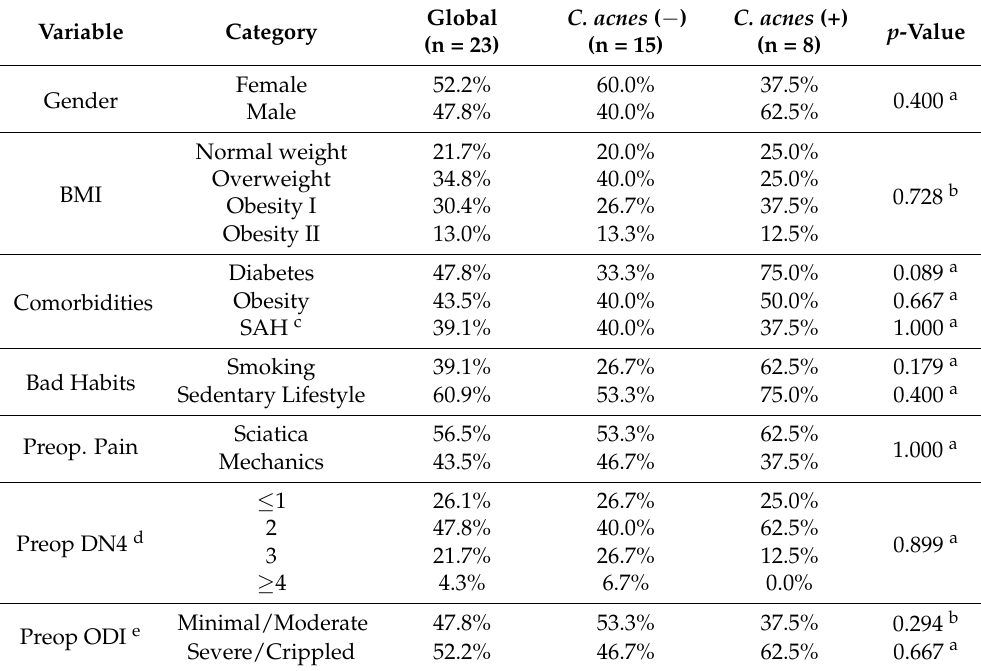
Table 3. Baseline Patients’ Characteristics Means According to Microbiological